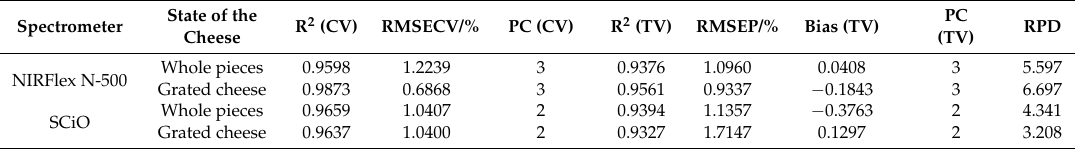
Figure 3. PLS regression of moisture content of whole pieces of cheese, established using data of NIRFlex N-500 ( a ) and SCiO ( b ). Table 3. Statistical parameterd of the established PLS-R models for moisture content. CV denotes cross-validated models, whereas TV refers to test set validated